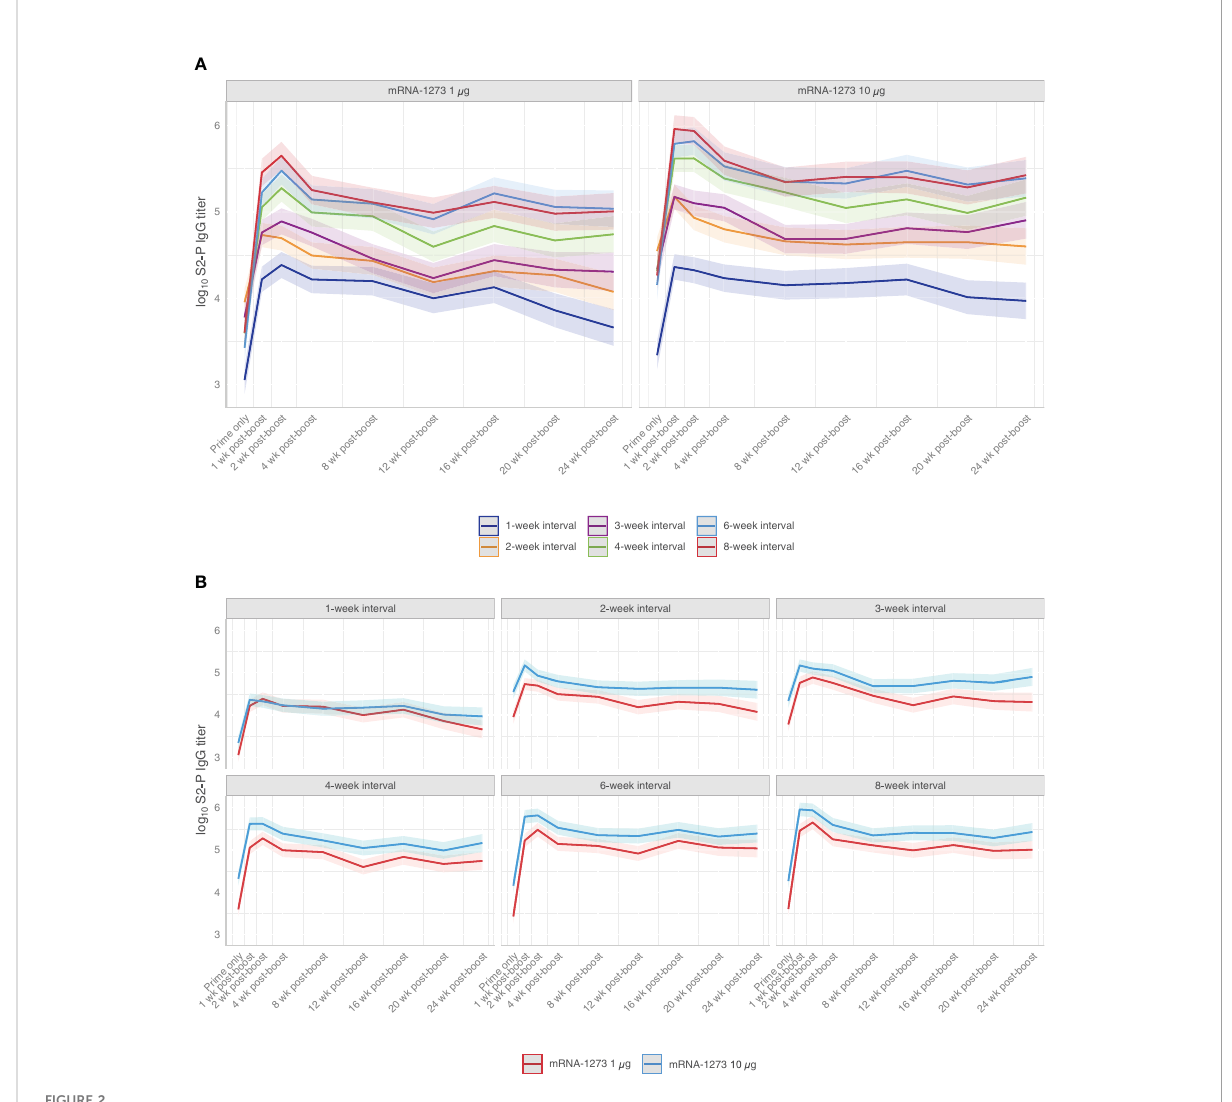
FIGURE 2 S2-P – speci fi c Serum Binding IgG Antibody Titers. Predicted S2-P serum binding IgG antibody titers (with corresponding 95% CIs [shaded region]; based on GAM with days after dose 2 as a continuous variable [see Methods for details]) from before dose 2 through 24 weeks following dose 2 are presented according to (A) mRNA-1273 dosing level (1 µg or 10 µg) or by (B) dosing intervals (1-, 2-, 3-, 4-, 6-, or 8- week intervals between doses) with n=8-10 mice per group. Results of statistical comparisons between groups based on GAM are presented in Table S1 and Figure S3. Observed data at individual animal level are shown in Figure S1. CI, con fi dence interval; GAM, generalized additive model; IgG, immunoglobulin G; mRNA, messenger